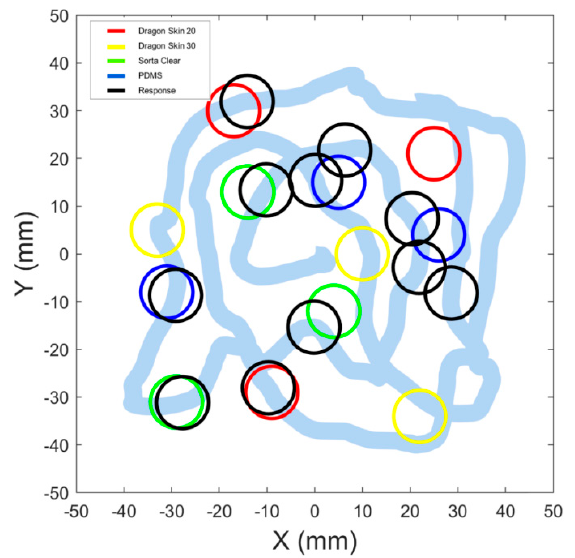
Figure 3. Example of responses given by a participant across an experimental session: colored circles mark the position of the inclusion set; black circles represent the position of the indenter when the subject pressed the key, and light blue line represents the trail of the probe on the phantom surface. Results show that an average of 63% and 60% of the inclusions were correctly perceived and declared within a tolerance of 10 mm to the nearest inclusion, for ILS and NILS experiments, respectively. In both cases, with a tolerance higher than the inclusion diameter (i.e., >10 mm), the rate of identified inclusions was slightly higher (Figure 4).